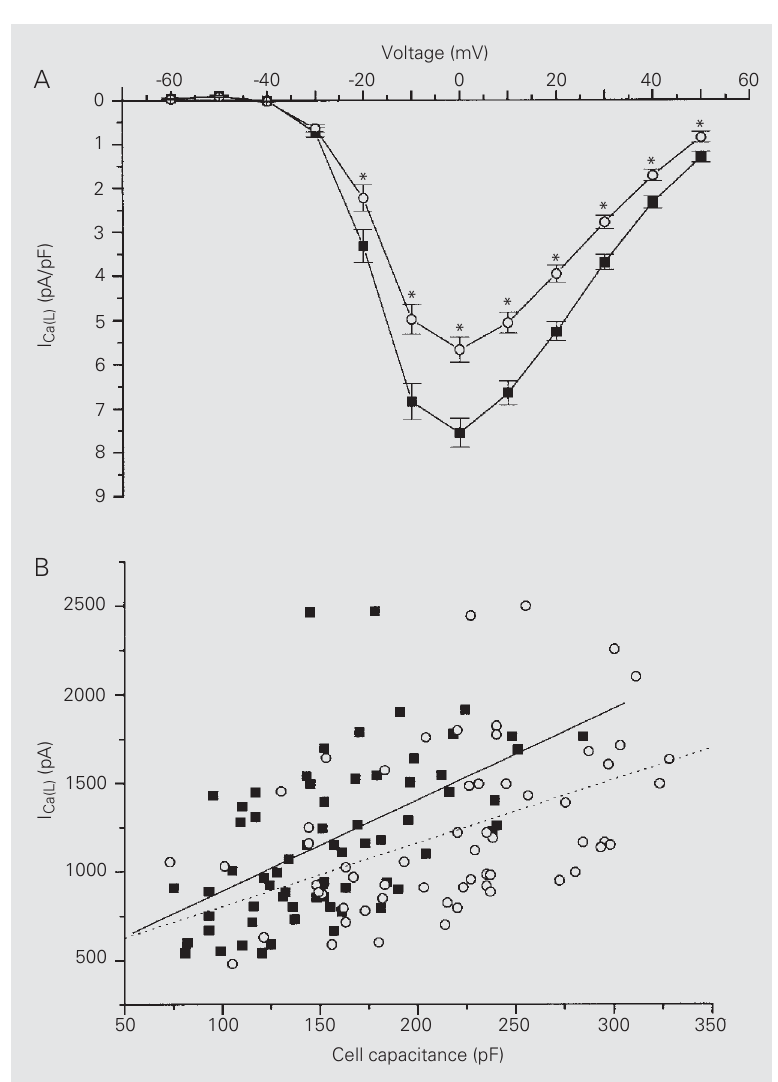
Figure 1. A , L-type calcium current (I Ca(L) ) versus voltage plots of sham (squares; N = 69) and postinfarction myo- cytes (circles; N = 60). Mean peak I Ca(L) density is signifi- cantly reduced in postinfarction myocytes. *P<0.05 com- pared to sham (unpaired Student t -test). B , Peak I Ca(L) versus cell capacitance plots of sham (squares) and postinfarction myocytes (circles). There is a linear rela- tionship between calcium current and cell capacitance in both groups (r = -0.48, P<0.001, linear regression, for postinfarction myocytes, N = 60; r = -0.54, P<0.001, linear regression, for sham myocytes, N = 69). Slope values obtained for regression lines did not differ (-3.59 ± 0.87 for postinfarction myocytes and -5.15 ± 0.97 for sham myocytes, P =